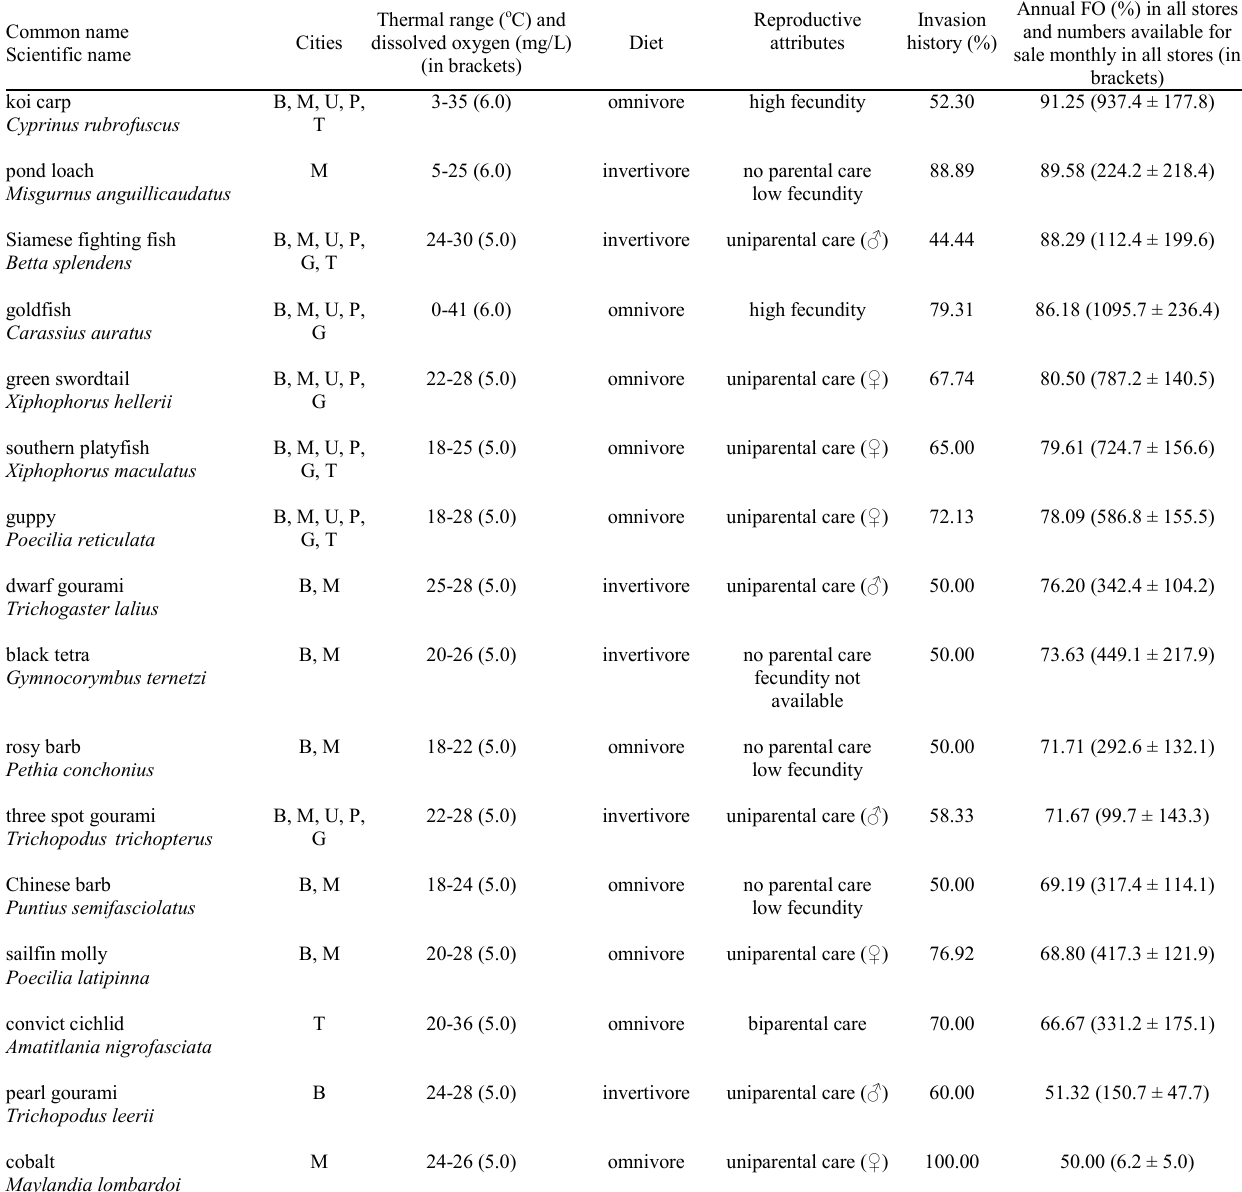
Table 3. Biological, historical and species frequency/numbers variables in 39 stores surveyed in Minas Gerais State. Only species with at least 50% occurrence are listed, in decreasing order of annual frequency of occurrence (FO). Cities: B =